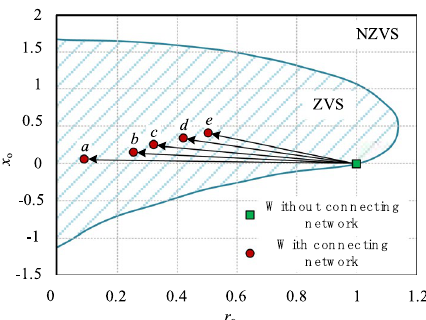
Fig. 4 Impedance moving direction after joining power combining